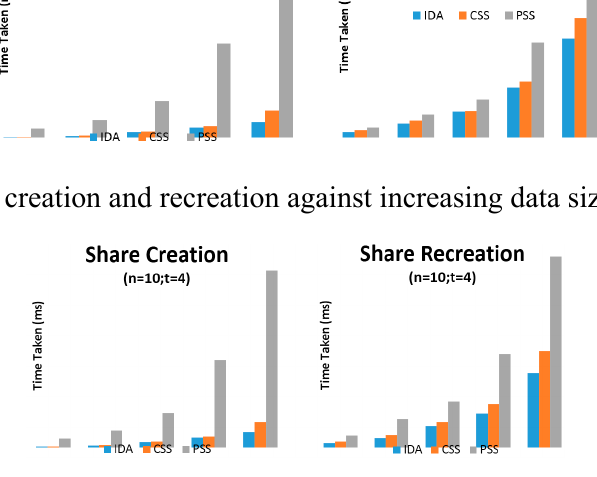
Figure 4. Share creation and recreation against increasing data sizes ( n = 10; t = 4).